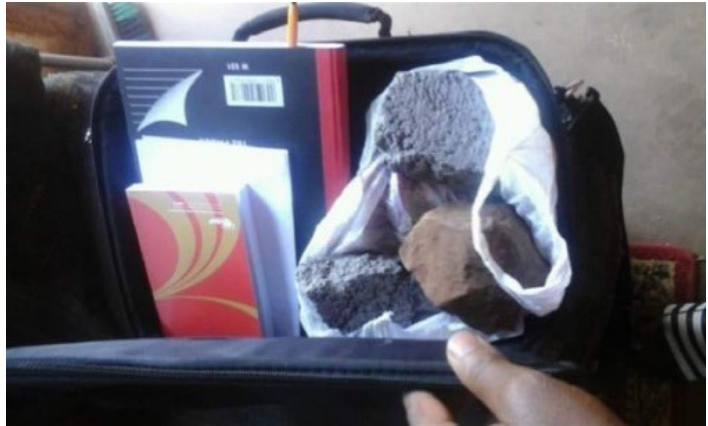
Figure 1: Establishing difference through